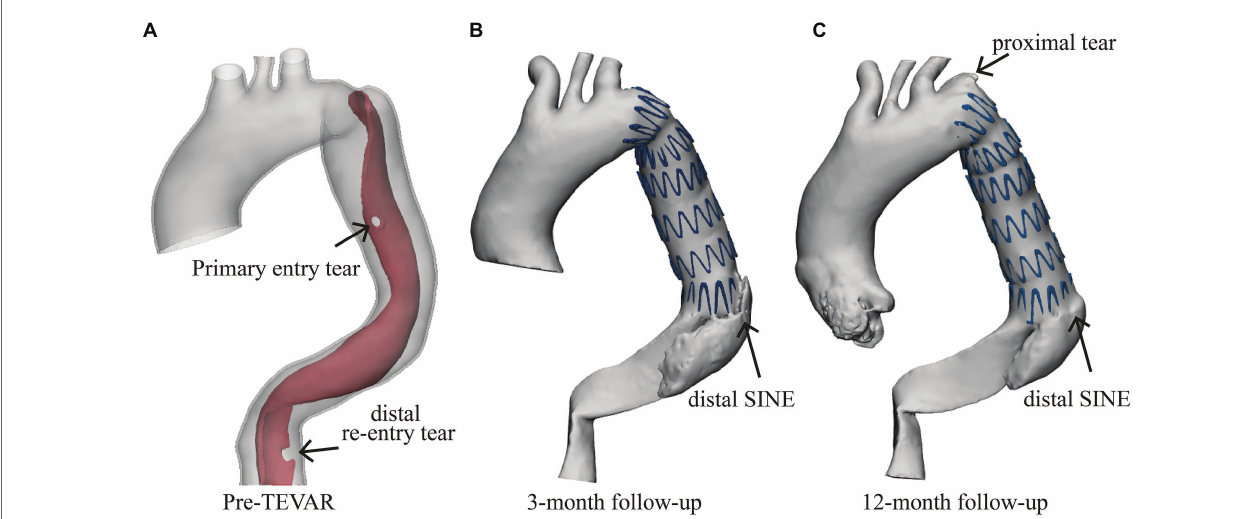
FIGURE 1 | Patient information. (A) The patient was diagnosed with type B aortic dissection with one primary entry tear and a distal re-entry tear (marked by the black arrow), (B) the distal stent-induced new entry (SINE) was found at the 3-month follow-up, and (C) a newly formed proximal tear was found at the proximal landing zone at the 12-month